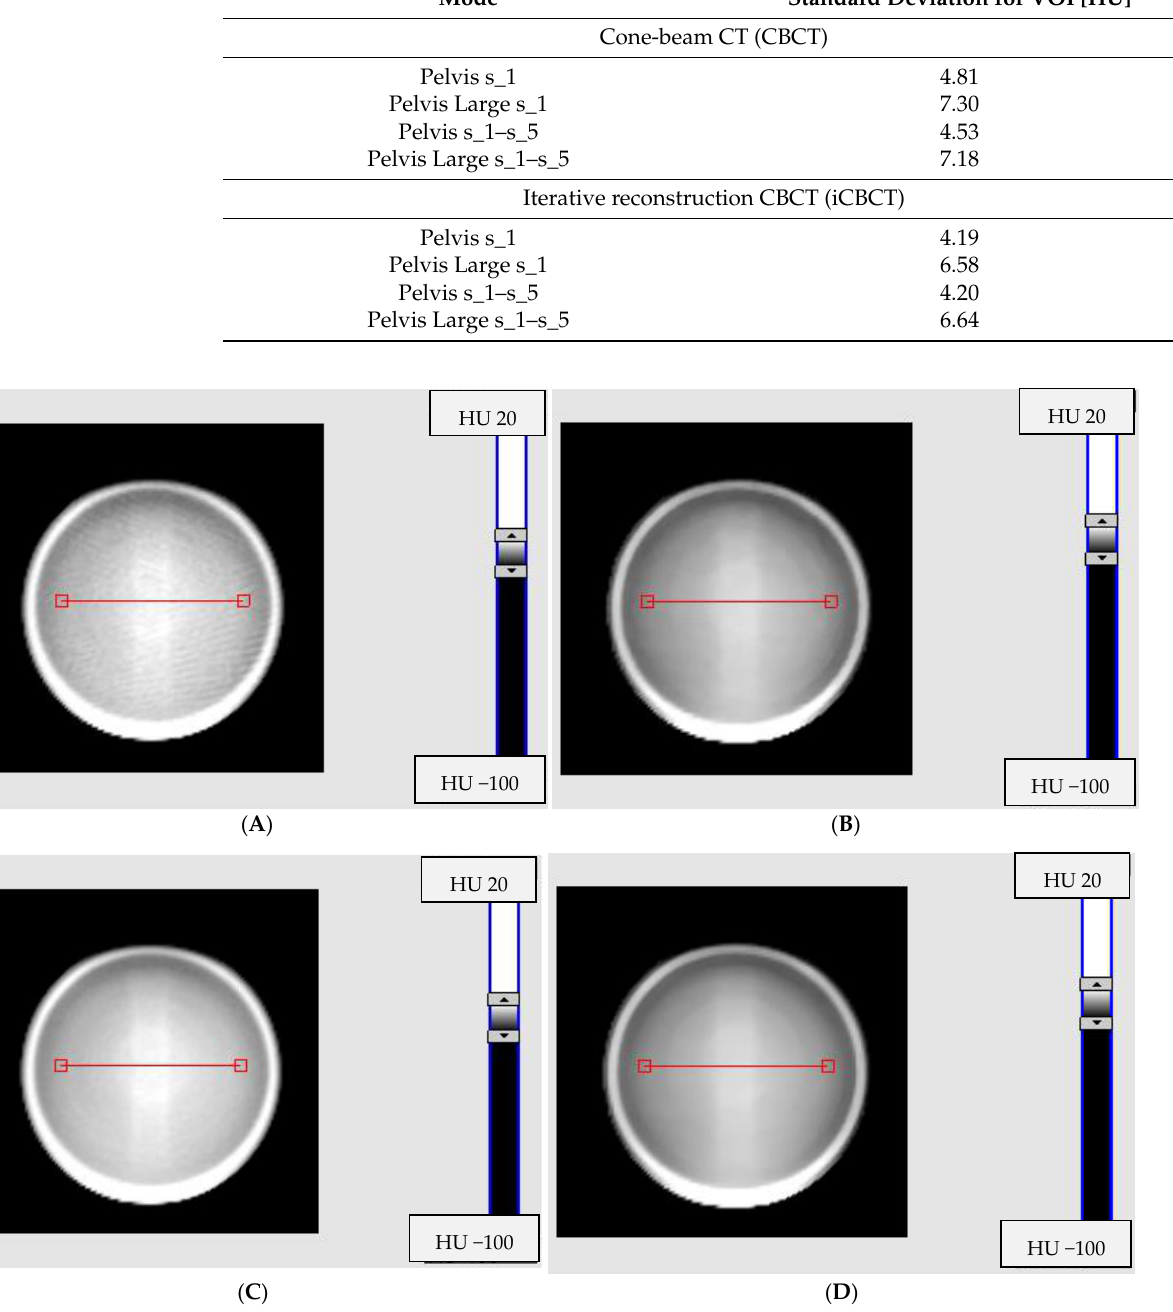
Figure 2. Profiles (as indicated in Figure 1) across the irradiated PABIG nx in the PH-5-DD2 GeVero Co. container (1 × 1 cm 2 , 10,000 MU) for a sample scanned with the TrueBeam accelerator equipped with CBCT and iCBCT. The results are shown for 1 and 1 – 5 series as the mean. Averaging the results over five series slightly lowered Std for CBCT; however, it did not improve it substantially for iCBCT (Table 5, Figures 1 and 2). This means that signal averaging for iCBCT is not a must, as it did not markedly improve image uniformity. One scan can be enough for iCBCT, which is advantageous in terms of reducing the overall scan time. 3.3. Impact of the Scanning Time Interval between Consecutvie Scanings on Image Uniformity Image uniformity was examined by using the Cathpan ® 504 phantom with the True- Beam (Table 6) and Halcyon accelerators (Table 7). The criterion of image uniformity was ±30 HU, i.e. , if the calculated image uniformity was ≤±30 HU (e.g. , signal of VOI for Left,